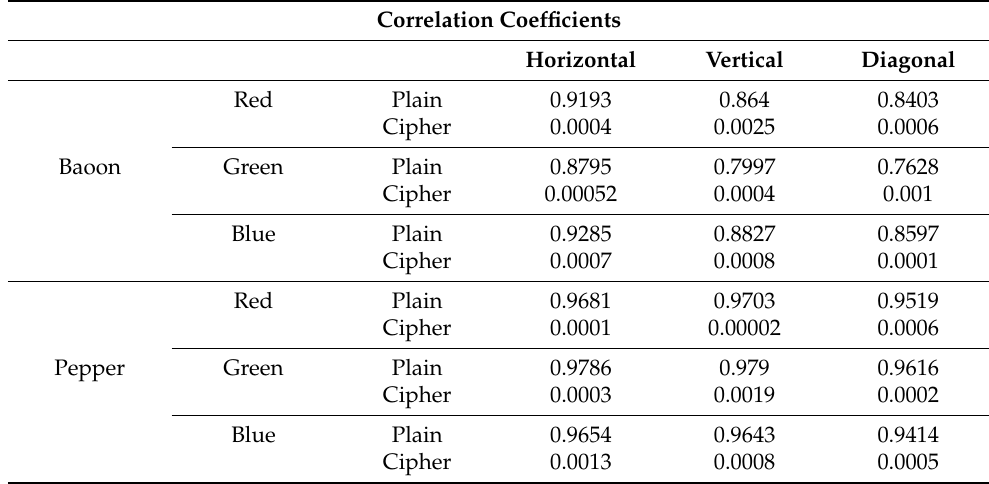
Table 3. The correlation coefficients of adjacent pixels in experimental images for all